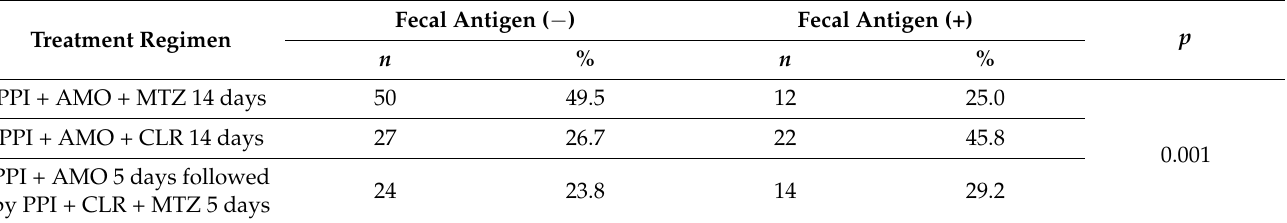
Table 3. The effectiveness of the prescribed